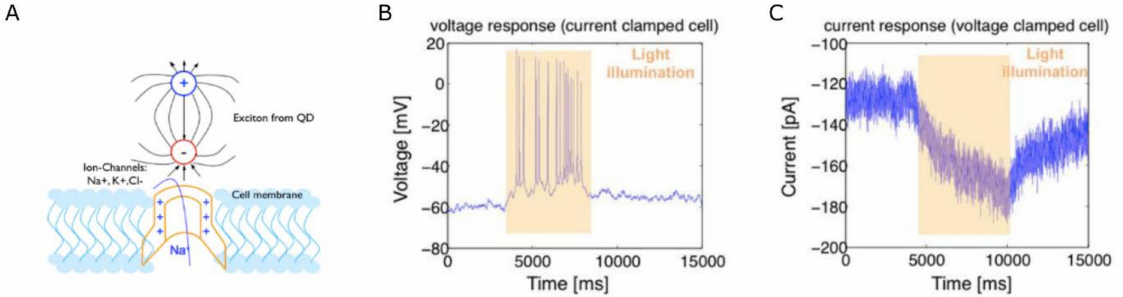
Figure 4. Opto-electric cell stimulation using QDs. ( A ) Schematic illustration of the interaction of a quantum dot with the cell membrane. ( B ) The voltage response of a current-clamped cortical neuron cultured on a CdSe QD film. ( C ) The current response of a voltage-clamped cortical neuron on a CdSe QD film. The figure is reprinted with permission from Ref. [187]. Copyright 2012 Optical Society of